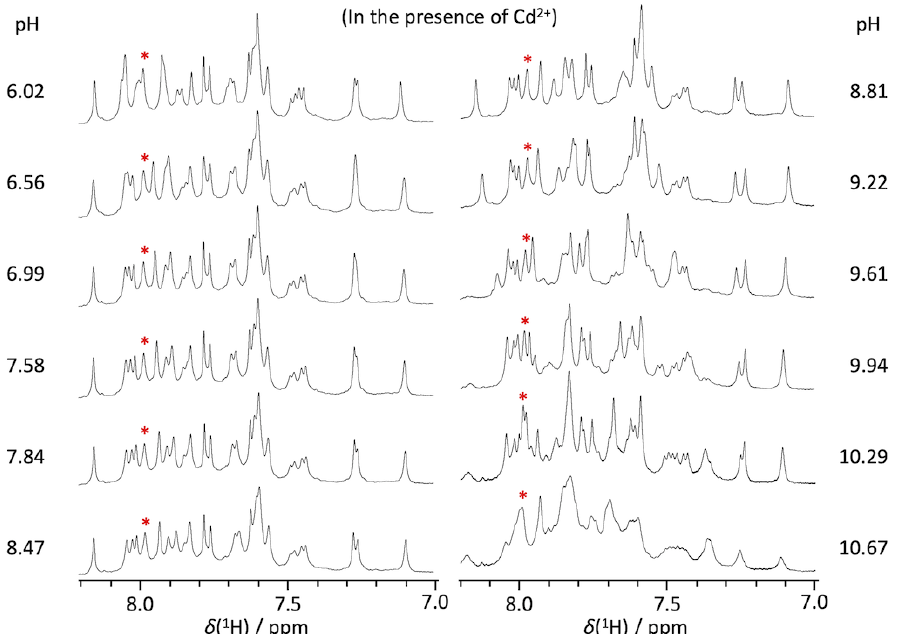
Figure 4. One-dimensional 1 H NMR spectra of the model RNA duplex 1 against various pH (basic region) in the presence of CdCl 2 (two molar equivalents (2 mM) against the metal ion-binding A9-G10.1 motif). The H8(G12*) resonance is labeled with a red asterisk in each spectrum. Although chemical shift perturbations for several resonances were observed, these resonances were assigned to terminal residues. Above pH 9.22, a metal-dissociation process due to the Cd 2+ -precipitation under basic pH was observed.